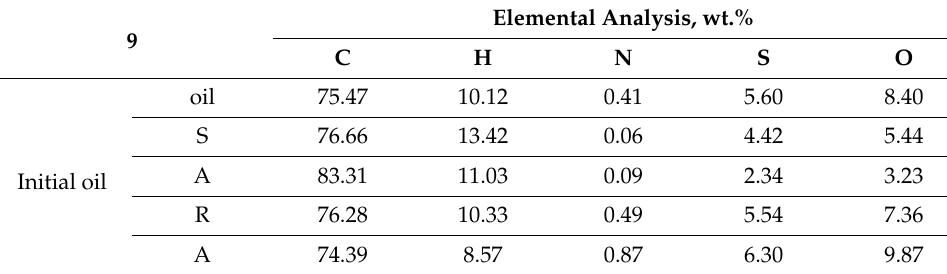
Table 3. Elemental analysis of the initial oil and its SARA